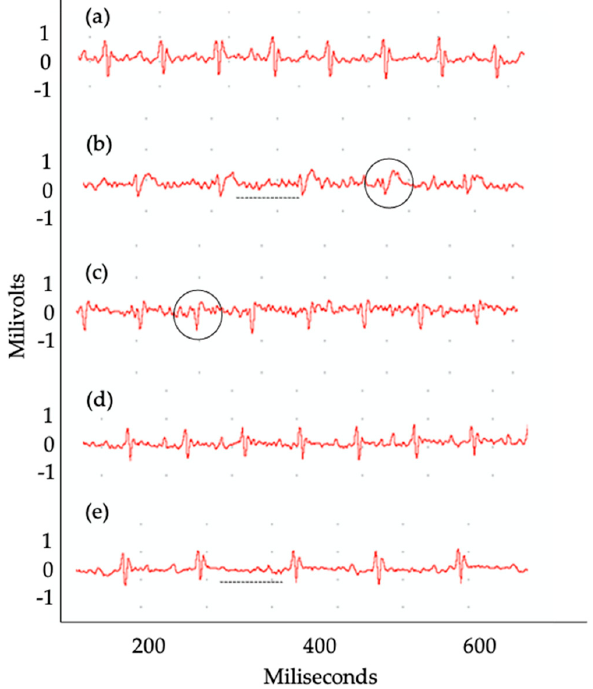
Figure 5. Electrocardiographic panel with examples of findings in electrocardiographic tracings in mice infected with different recombinant strains of T. cruzi at 30 dpi ( a – e ). Representative electrocardiographic tracings of animals from the following groups: ( a ) NI, ( b ) WT, ( c ) OE, ( d ) KO +/ − , and OE KO +/ − . Dashed lines indicate sinus bradycardia. Circles indicate atrioventricular block.